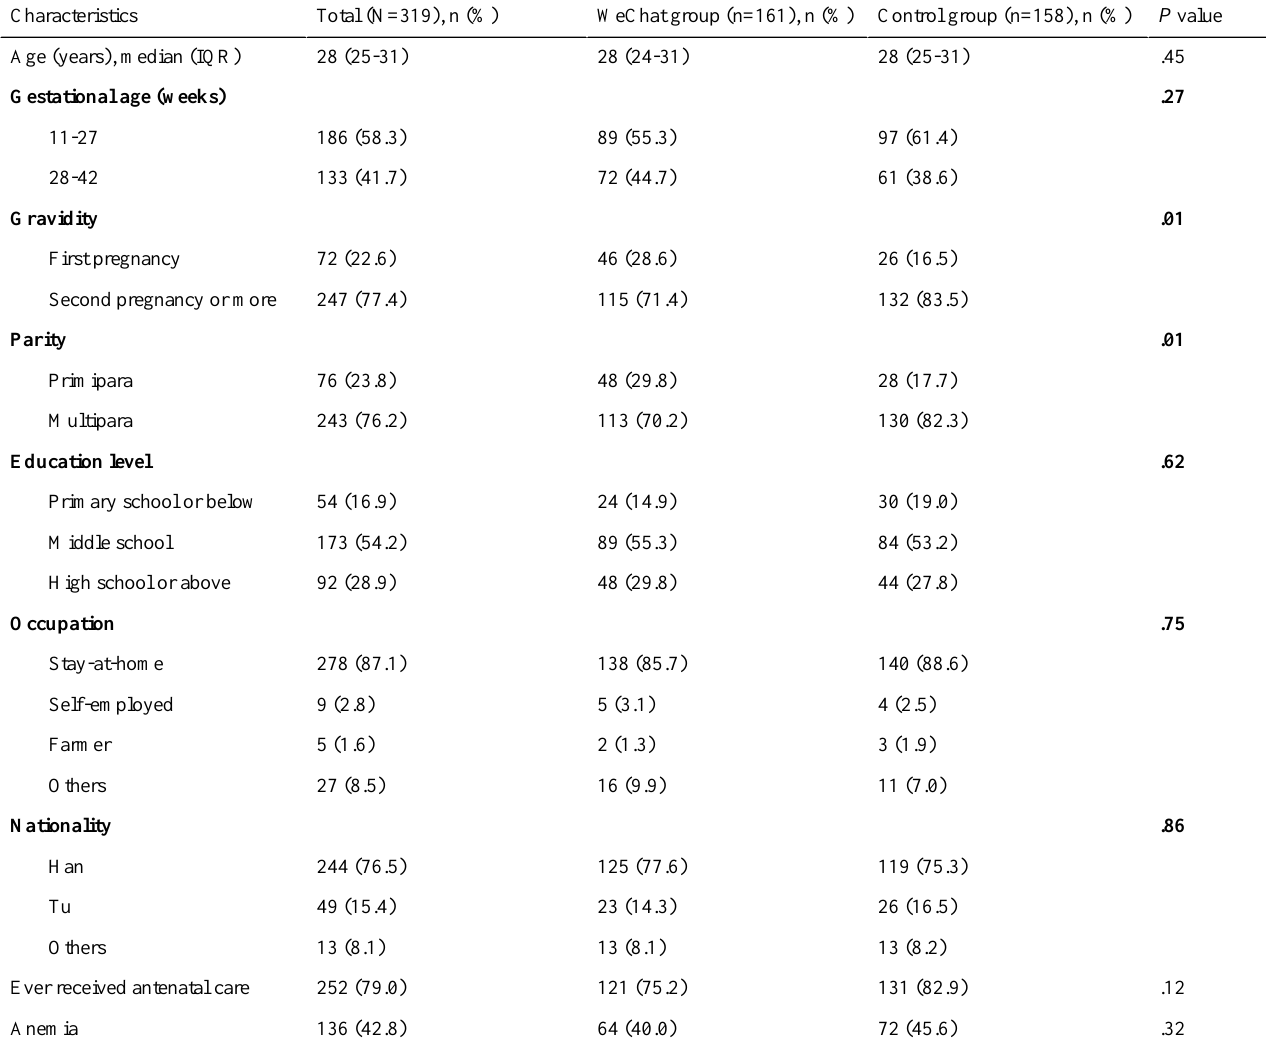
Table 1. Baseline characteristics of participants by treatment